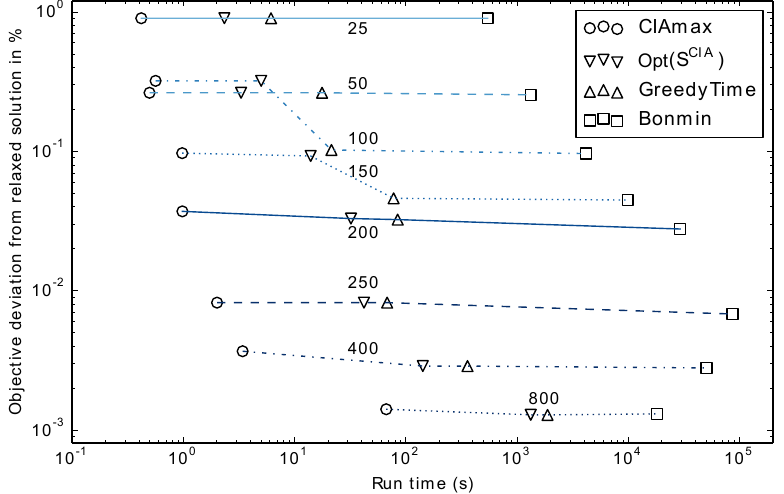
Figure 7. Log plot of run time and objective value deviation from the relaxed solution of the constructed solutions for different approaches and for the Lotka–Volterra multimode problem, with differential state discretization N = 12,000. The numbers in the plot indicate the applied corresponding number of control grid points M . We illustrate the outcomes of the solutions constructed by (CIAmax), Opt p S CIA q , the GreedyTime recombination heuristic, and the MINLP solver Bonmin. By Opt p S CIA q , we denote the best objective value outcome of over all MILP solutions. For each control discretization, we connect the outcomes of the four approaches with lines in order to compare the behavior for different discretizations. One observes the convergence of all approaches towards the lower bound provided by the relaxed solution and the closure of the gap between (CIAmax) and Bonmin solutions for a fixed discretization. GreedyTime is roughly two orders of magnitude slower than (CIAmax), but is faster than